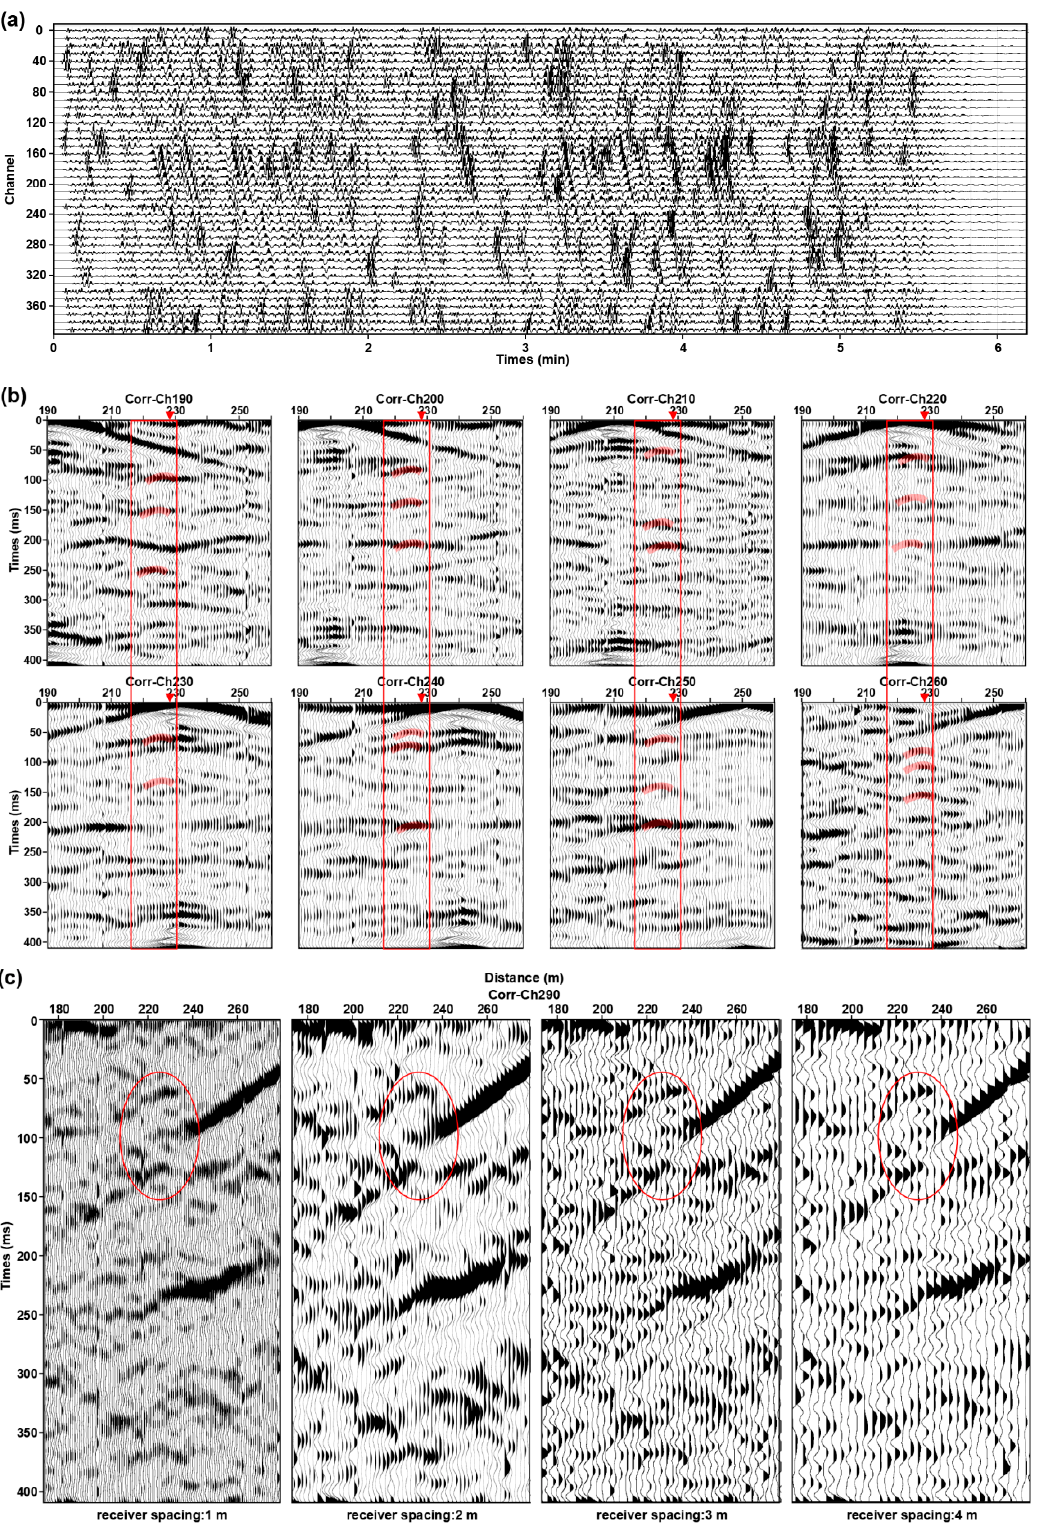
Figure 10. Display of microtremor numerical simulation results. ( a ) is numerical simulation microtremor data. ( b ) are CC with 1 m receiving point spacing. The virtual sources are located at the hanging wall and footwall of the normal fault. ( c ) are CC with different receiver spacing.